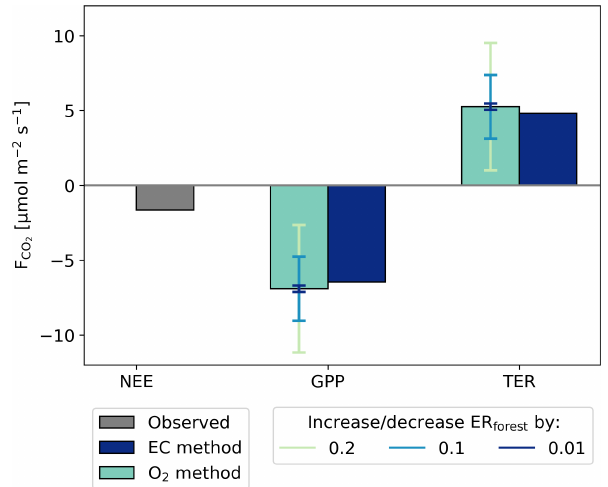
Figure 8. The CO 2 fluxes of a second representative day (13 through 15 June) for net ecosystem exchange (NEE), gross pri- mary production (GPP), and total ecosystem exchange (TER) based on two different methods: the EC method and the O 2 method. The different error bars indicate an increase/decrease of 0.2, 0.1, or 0.01 for the exchange ratio of the forest (ER forest ) used in the O 2